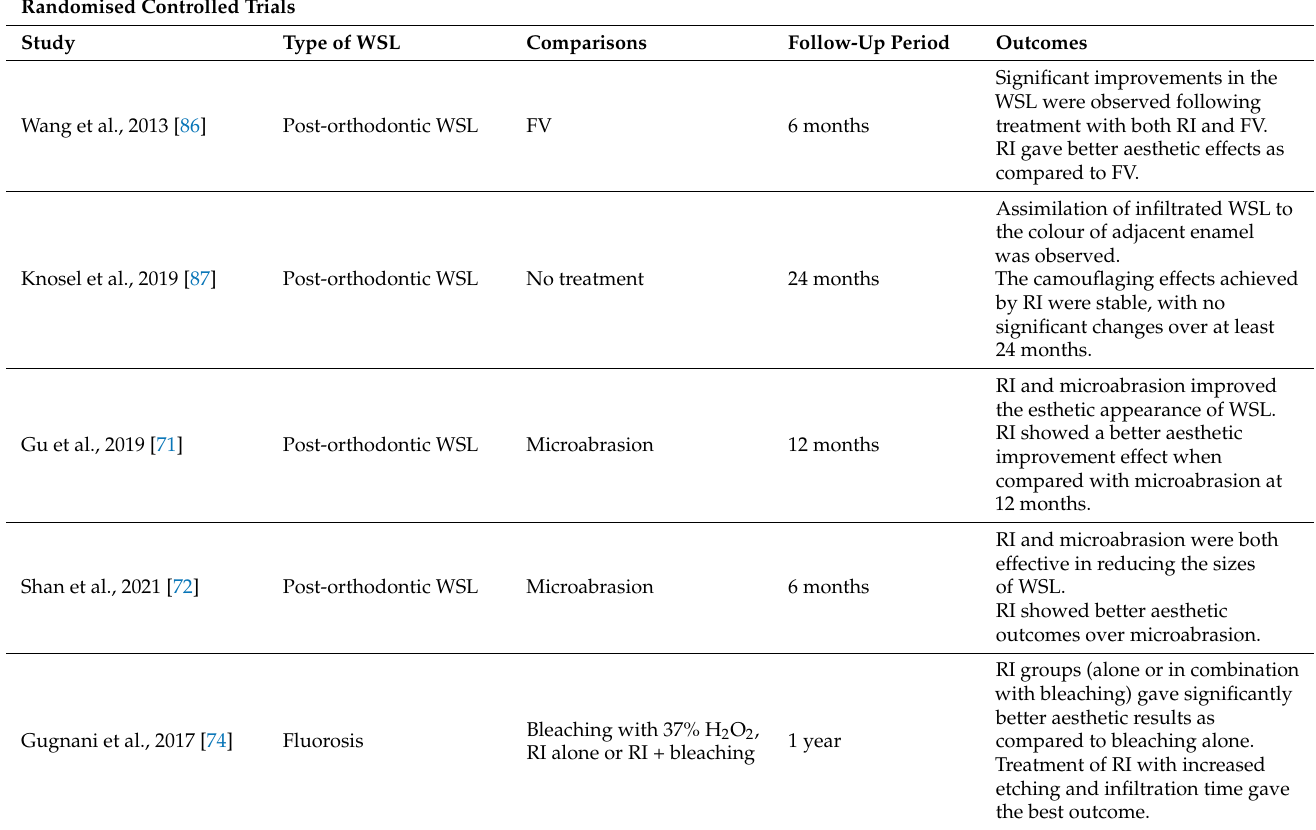
Table 3. Summary of main studies on the ability of RI to improve the anterior